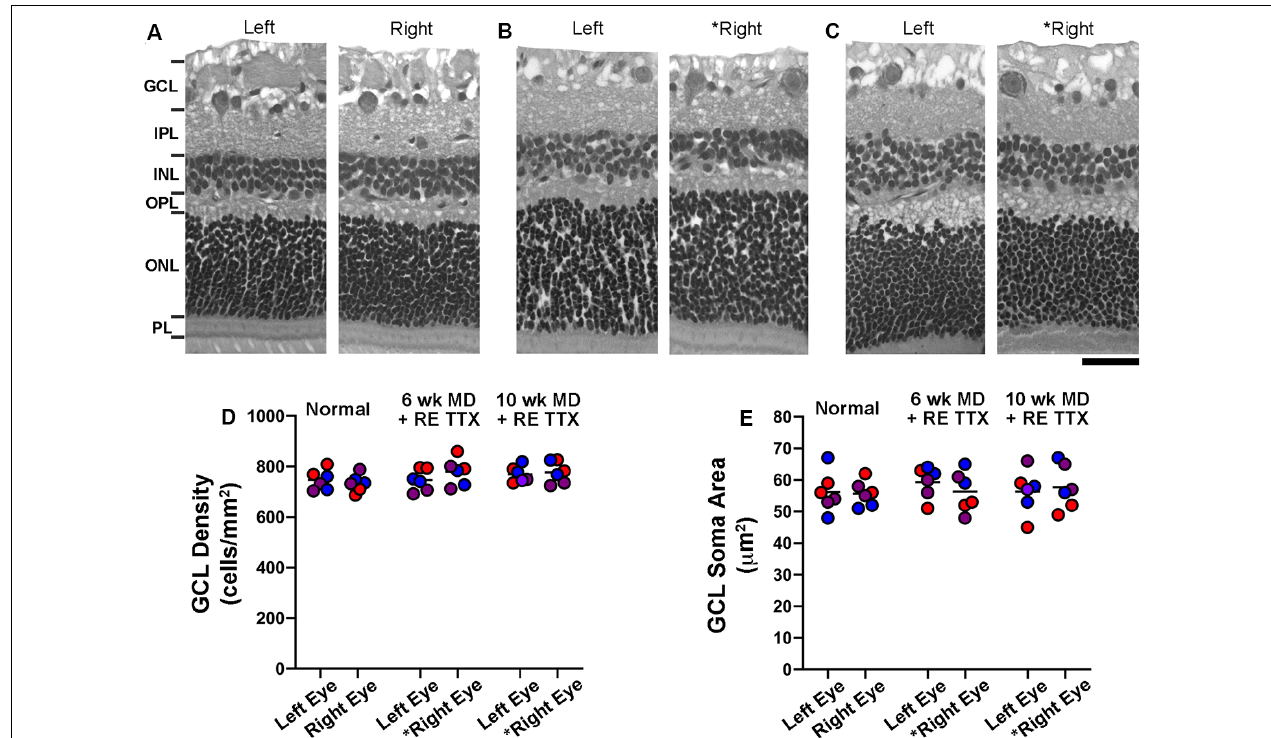
FIGURE 2 | Stereological quantification of cell density and cross-sectional soma area in the ganglion cell layer (GCL) following 10 days of monocular retinal inactivation. Retinal cross-sections from the left and right eye of a normal animal (A) and two animals subjected to MD for either 6 (B) or 10 (C) weeks both followed by retinal inactivation for 10 days. Measurement of cell density within the GCL revealed no difference between left and right eyes of normal animals, nor was there a difference in cell density between the retinae of monocularly deprived animals that had their right eyes inactivated (D) . Quantification of retinal ganglion cell soma size also revealed no difference between the left and right eyes of normal animals or those subjected to monocular retinal inactivation (E) . Colored symbols in (D,E) represent measurements taken from sections of retina cut through the nasal calotte (blue), temporal calotte (purple), and central retina (red). Asterisks indicate the inactivated eye. Scale bar = 40